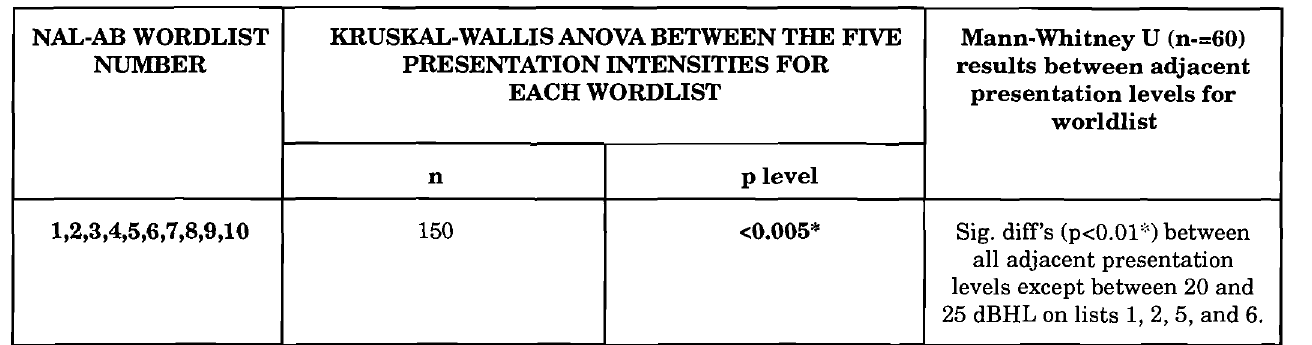
TABLE 4: Results of Tukey analysis for differences (p<0.05) in South African English speakers' mean scores between wordlists when p'resented at the same presentation intensity, e.g., lists 8 and 5 showed significantly different scores when presented at 0, at 20, and at 25 dBHL, but not at 5 or at 10 dBHL. NAL-AB List